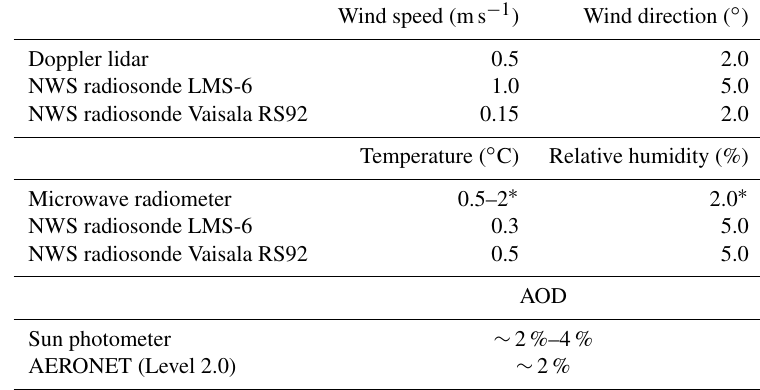
Table 1. Measurement accuracies reported by the manufacturer.